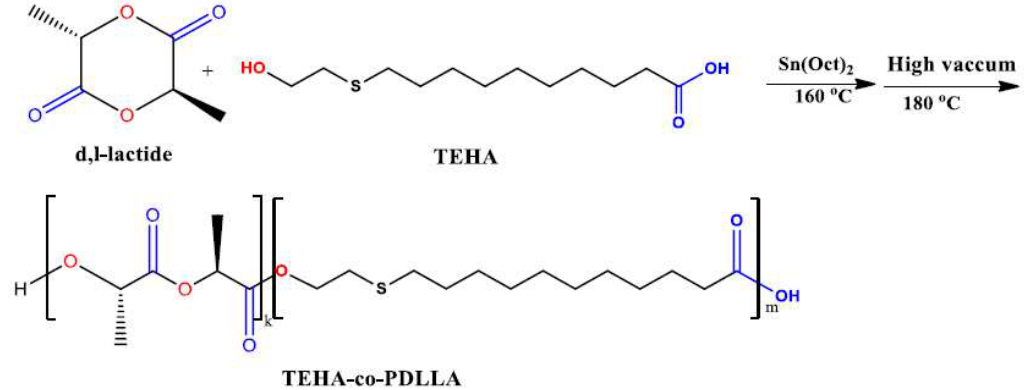
Figure 1. Synthesis route of TEHA-co-PDLLA semitelechelic block copolymer.